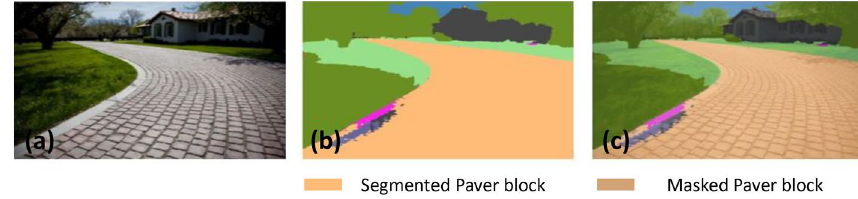
Figure 10. Offline results: paver block.